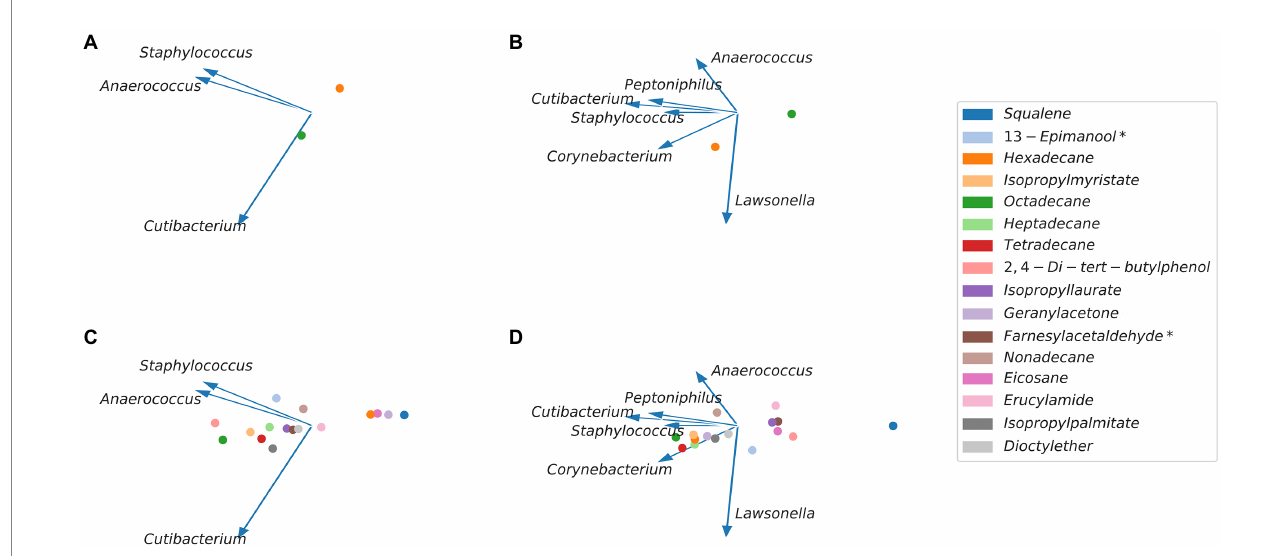
FIGURE 5 Microbe-metabolite vectors (mmvec) embedding of bacteria identified with the cultural approach and volatiles identified on the FFAP column (A) and DB-5 column ( C ) and mmvec embedding of bacteria identified with the sequencing approach and volatiles identified on the FFAP column (B) and on the DB-5 column (D) . The bacteria are visualized by blue arrows and volatiles by colored dots. Bacteria that often occur together show a small angle between their respective arrows (e.g., Staphylococcus and Anaerococcus ). Volatiles that show a high co-occurrence exhibit a low Euclidean distance to each other (e.g., tetradecane and octadecane). Arrows pointing toward the same direction as volatiles indicate microbe-volatile co-occurrences.